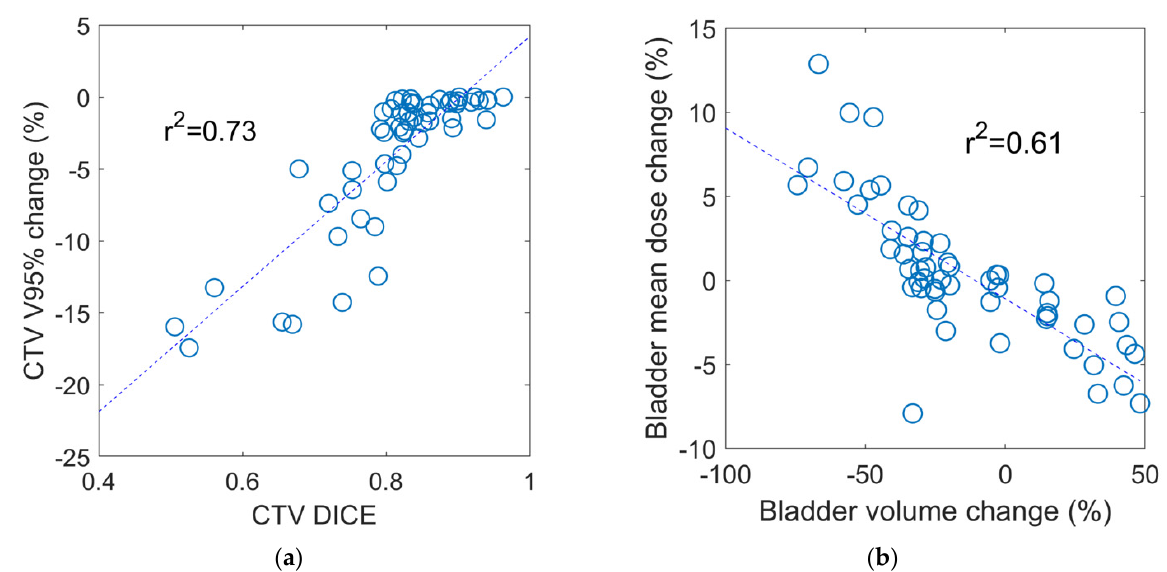
Figure 3. Correlation between dosimetric parameters versus interfractional geometric variations. ( a ) Change in CTV V95% versus CTV DICE (R2 = 0.73) ( b ) bladder mean dose change versus bladder volume change (R2 = 0.61). No strong correction was observed for the rest of the dosimetric metrics with neither volume nor shape changes. Table 3. Interfraction volume and dosimetry among patients with acceptable and unacceptable CTV V95% coverage.